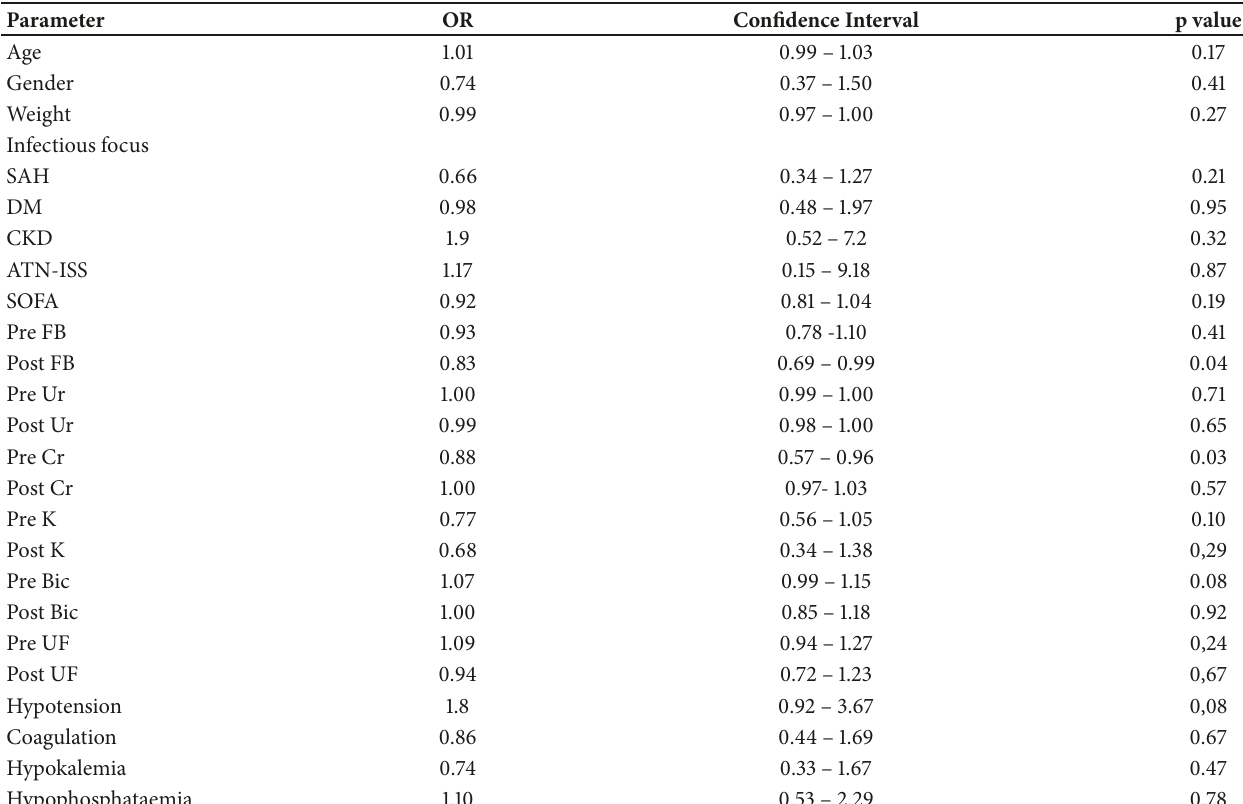
Table 7: Univariate logistic regression of clinical and laboratory characteristics and dialysis complications associated with the recovery of renal function in patients with AKI treated with PHD.